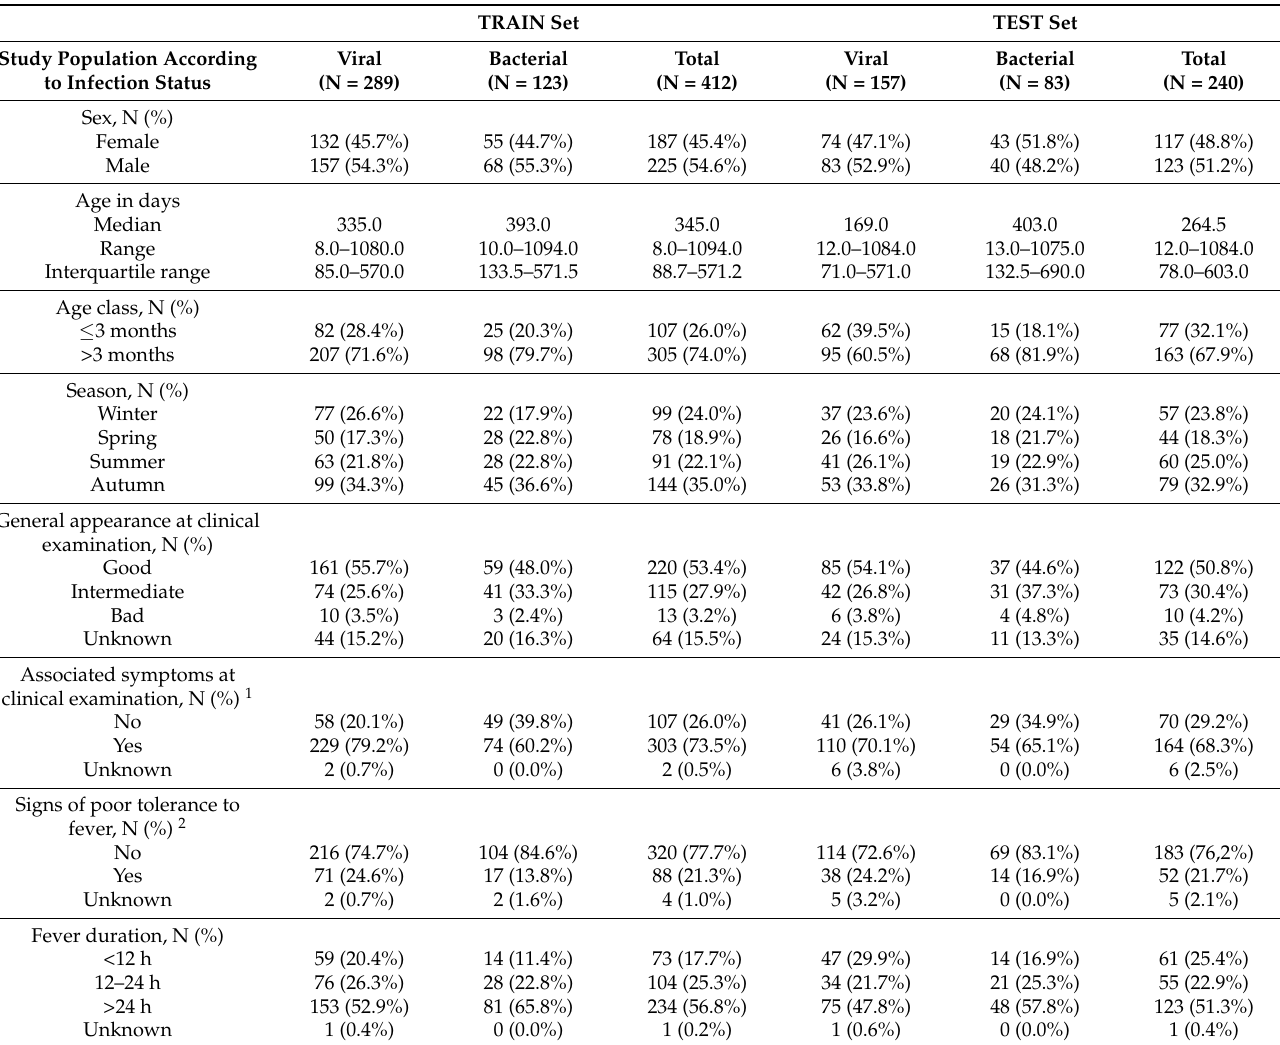
Table 2. Patients’ characteristics in TRAIN and TEST sets, according to the viral or bacterial infection